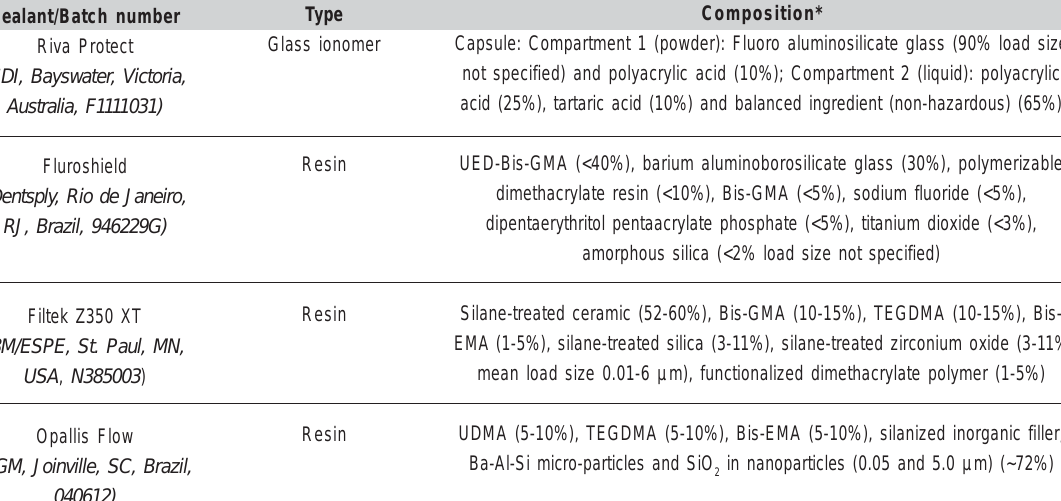
Table 1 - Compositions of materials used as sealants in